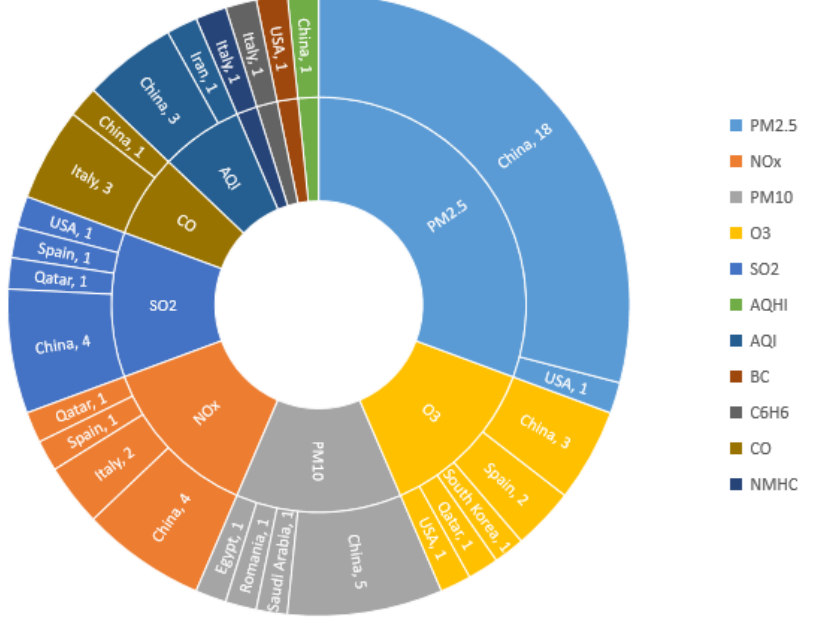
Figure 9. Countries distribution per